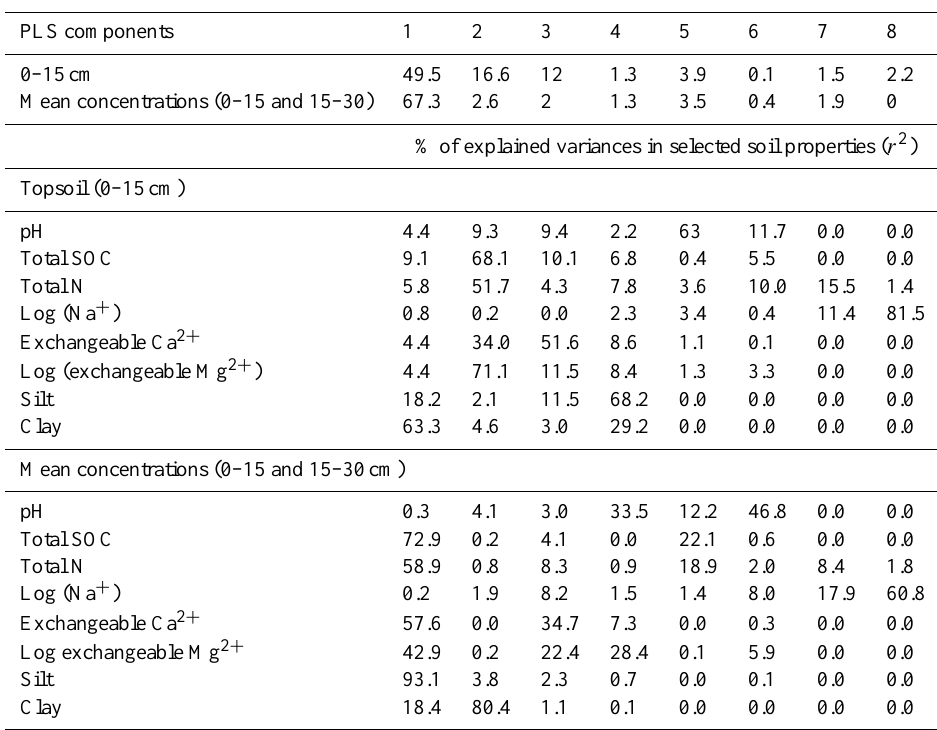
table. The explained variances for the first PLS component were as high as 93.1 % for silt and 72.9 % for SOC. The third PLS component registered relatively high explained variance for exchangeable bases, particularly Ca 2 + exhibiting 51.6